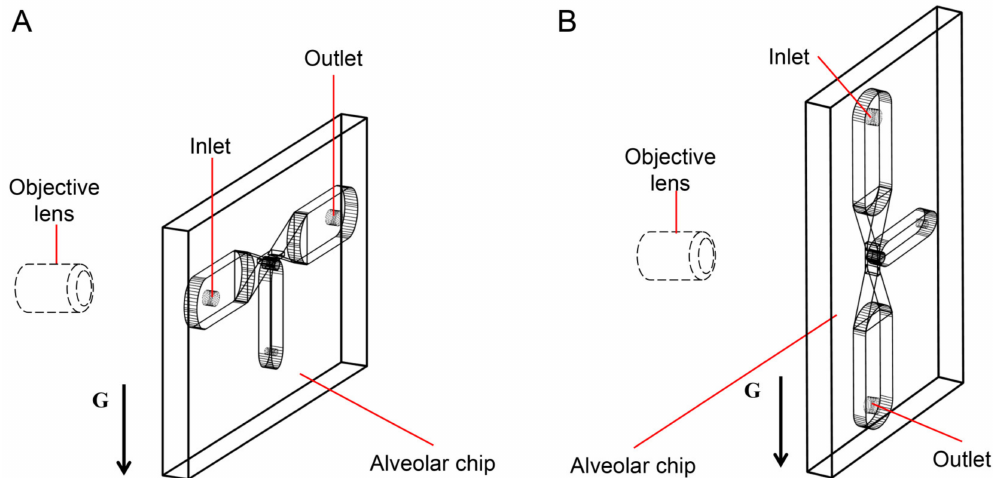
Figure 2. The gravity directions. ( A ) Perpendicular to the axis of the alveolar duct. ( B ) Parallel to the axis of the alveolar